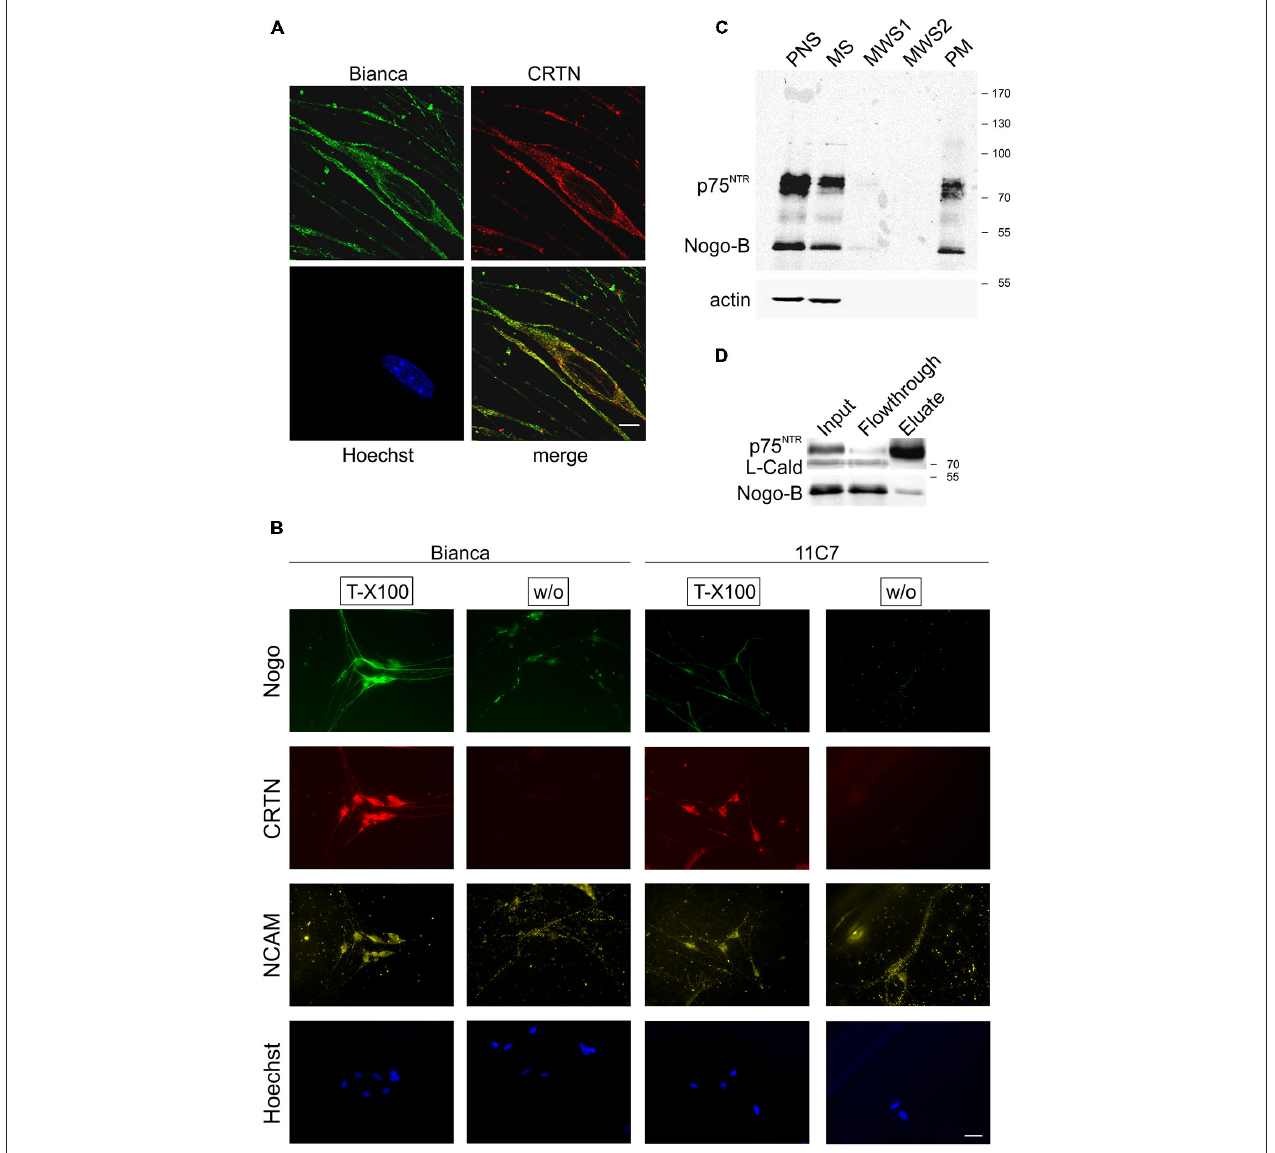
FIGURE 2 | Nogo-B localizes to the ER and the plasma membrane of Schwann cells. (A) Confocal images of cultured primary Schwann cells. Nogo predominantly exhibits a reticular subcellular localization and co-distributes with the ER marker calreticulin (CRTN). A single confocal section is shown. Scale bar is 5 µ m. (B) Bianca prominently stains fixed and permeabilized (Triton X-100) primary Schwann cells whereas 11C7 gives only a weak signal indicating that, similar to sciatic nerve immunohistochemistry, most of Bianca immunoreactivity is due to Nogo-B. When omitting the permeabilization step (without Triton X-100) some Bianca immunoreactivity remains indicating surface expression of Nogo-B on Schwann cells. In contrast, no 11C7 signal is seen on non-permeabilized cells demonstrating absence of Nogo-A from the Schwann cell plasma membrane. CRTN serves as a negative control for plasma membrane staining, NCAM as a positive control. Scale bar is 50 µ m. (C) Plasma membrane sheets of primary Schwann cells were enriched and fractions of the enrichment procedure were assayed by Western blotting. Equal amounts of protein (15 µ g) were loaded in postnuclear supernatant (PNS) and microsomal supernatant (MS). The membrane pellet was washed with 350 µ l and a 70 µ l aliquot was loaded of each of the two membrane washing supernatants (MWS1–2). The final PM pellet was resuspended in 100 µ l 1 × Laemmli buffer and a 25 µ l aliquot was loaded. The neurotrophin receptor p75 NTR serves as a positive control for plasma membrane localization, actin serves as a negative control. Nogo is detected with Bianca; while Nogo-B (approx. 50 kDa) is abundant in the PNS, MS as well as PM fraction, Nogo-A (approx. 180 kDa) is not detected in either fraction. (D) Proteins at the surface of Schwann cells were biotinylated and fractions were analyzed by Western blotting. p75 NTR serves a positive control for surface expression, L-caldesmon as a negative